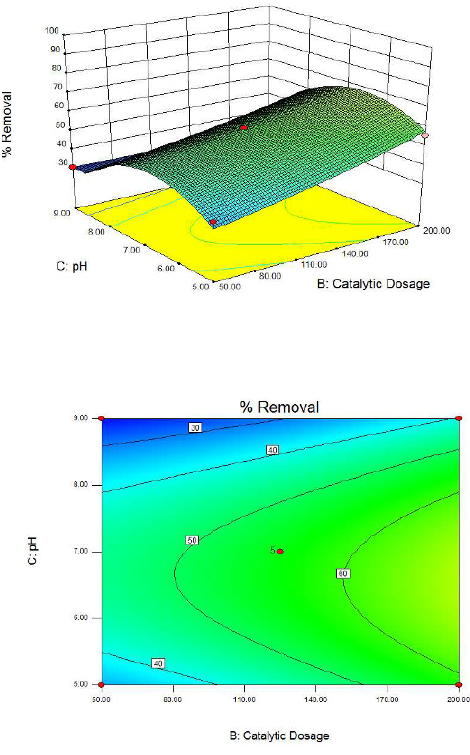
Figure 5. 3D Response surface (Top) and contour plots (Bottom) showing the interaction between Dye effluent concen- tration and Irradiation time for solar induced photocat- alytic decolourization of dye effluent (Catalyst dosage 125 mg L − 1 ; pH 7).